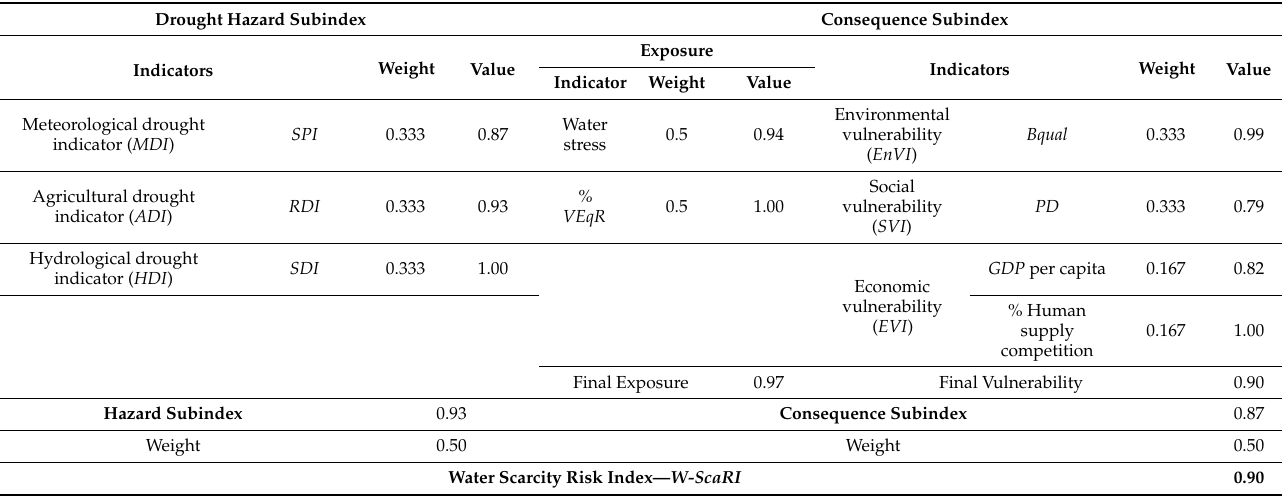
Table 20. W-ScaRI calculation for RJMR—January 2015.